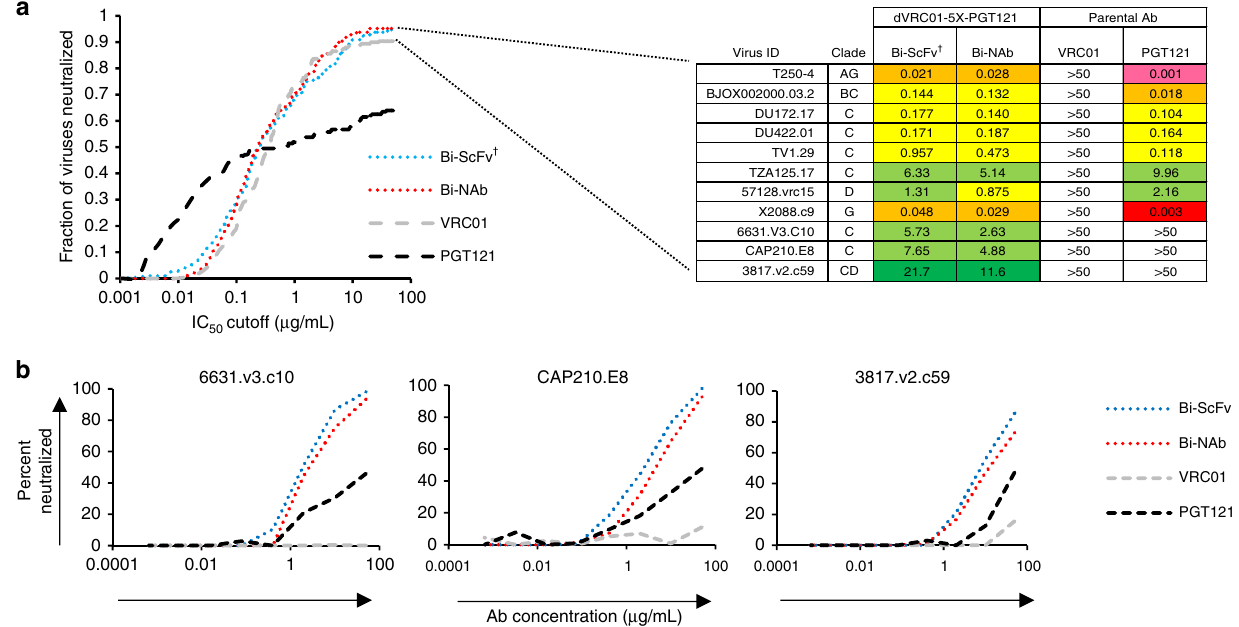
Fig. 5 Bispeci fi c antibody neutralization potency-breadth curves. a Potency-breadth curves comparing the bispeci fi c antibodies to their parental IgGs in the neutralization assay with 208 viral strains (left panel) and summary of IC 50 titers ( μ g/mL) against VRC01-resistant and dual-resistant viruses that are sensitive to the bispeci fi c antibodies (right panel). ( † indicates that the IC 50 was adjusted by a factor of 3 to account for the molarity difference between the lower molecular weight Bi-ScFv and the IgG or Bi-NAb). b Raw neutralization curves of dual-resistant viruses sensitive to the Bi-ScFv and Bi-NAb in